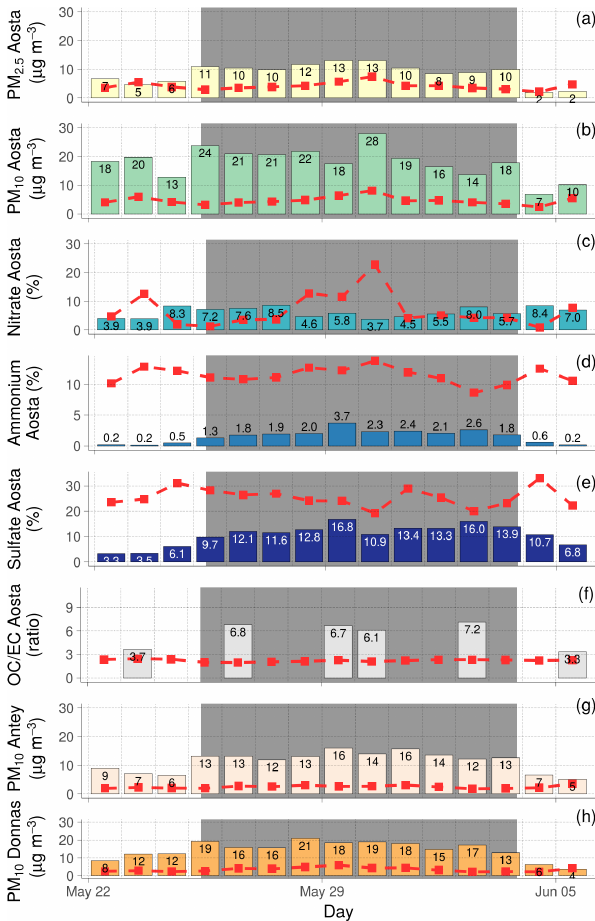
Figure 13. Measured (coloured bars) and simulated (dotted line) PM 2 . 5 and PM 10 concentrations at several sites of the Aosta Val- ley (a, b, g, h) ; percentage concentrations of nitrate (c) , ammo- nium (d) , and sulfate (e) and OC / EC ratio (f) at Aosta–downtown during case study 3 (May–June 2017). The period when the ALC detects a thick layer above Aosta–Saint-Christophe is highlighted with a grey